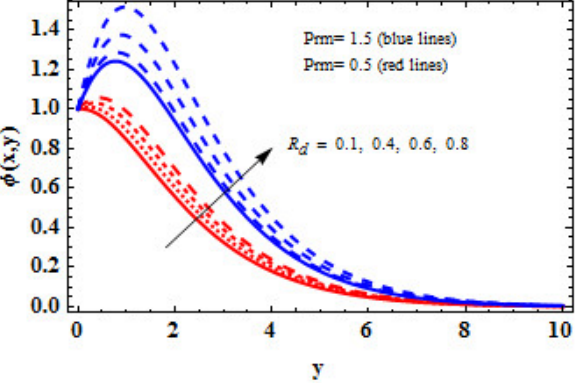
Figure 11.  effect on concentration with respect to  . Figure 11. M effect on concentration with respect to Prm .